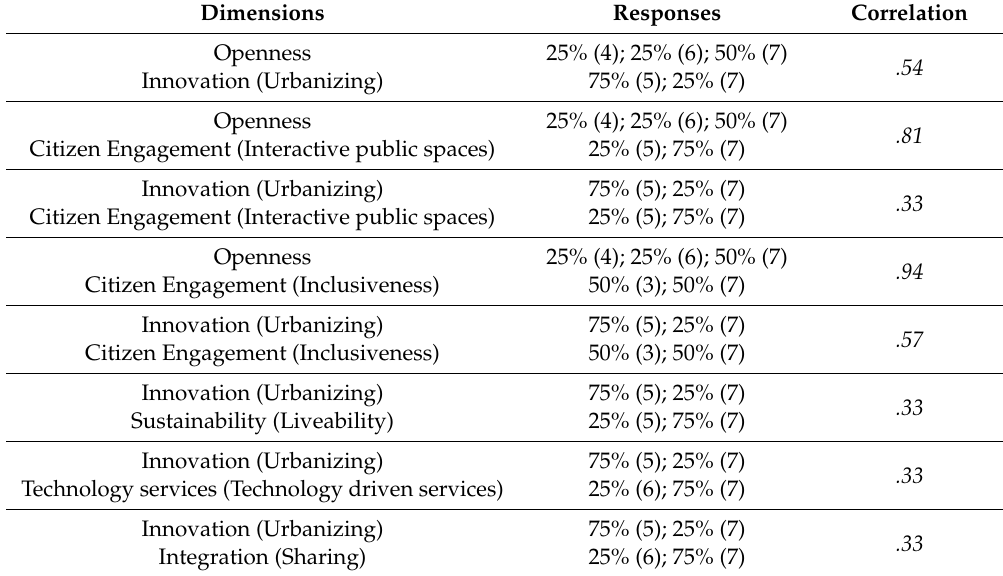
Table 3. Responses and correlations for selected dimensions of